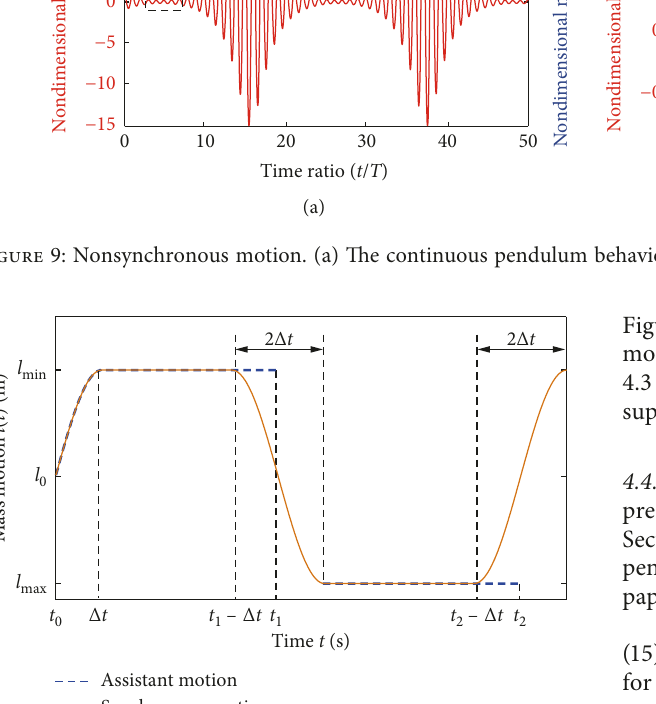
Assistant motion Figure 10: Diagram of synchronous motion method.